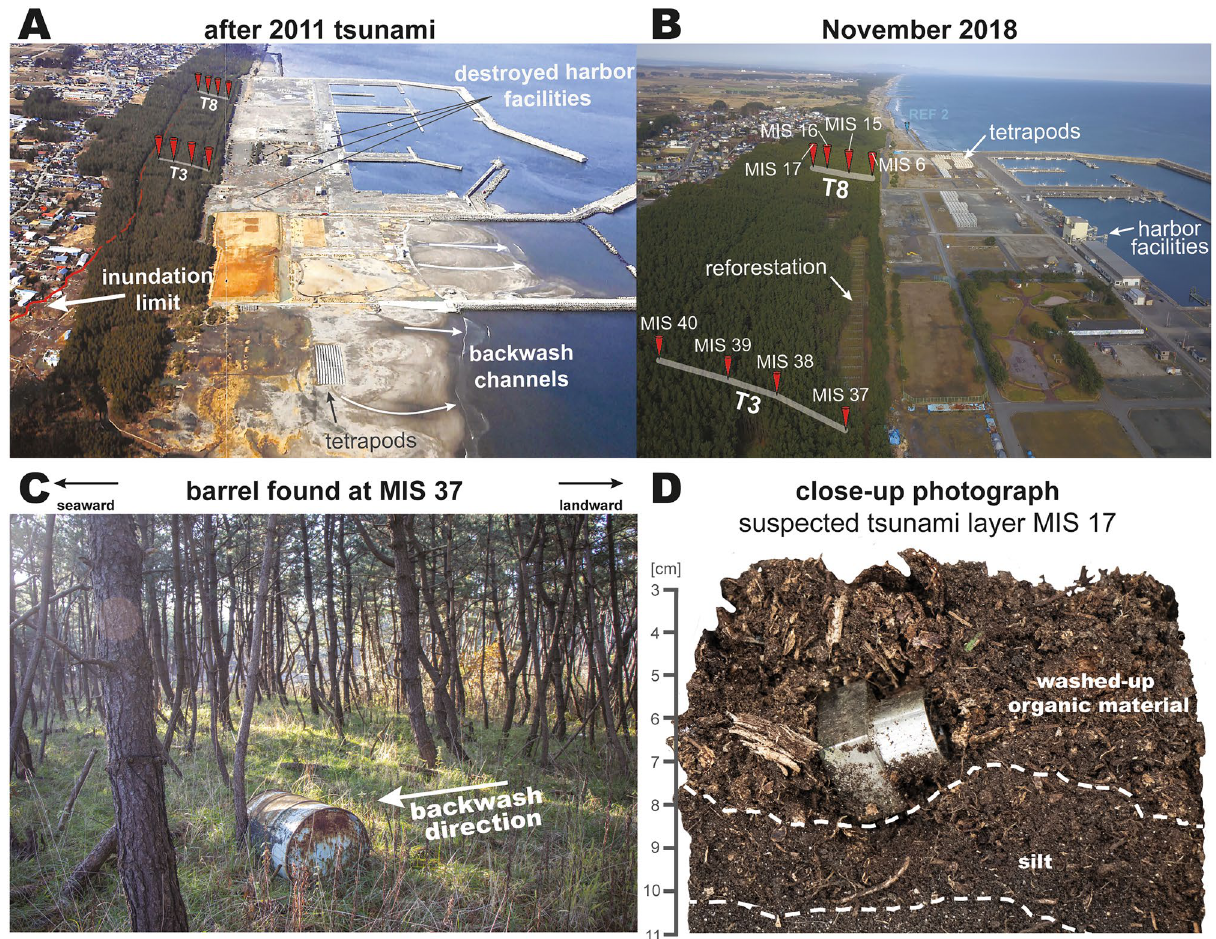
Figure 2. ( A ) Aerial photograph of the Misawa harbor directly after the 2011 tsunami showing the destruction and sediment distribution 24 . ( B ) Aerial photograph of the Misawa harbor during fieldwork in 2018 with the harbor rebuilt and reforestation efforts. ( C ) Barrel found in the forest at transect T3 leaning against a tree in backwash direction. ( D ) Close-up photograph of a suspected tsunami layer in MIS 17, consisting of washed-up organic material and containing a floatable plastic particle. Photographs were taken by author (Piero Bellanova) and photograph plate was illustrated using Adobe Illustrator (Creative Cloud version 2020, https:// adobe. com/ produ cts/ illus